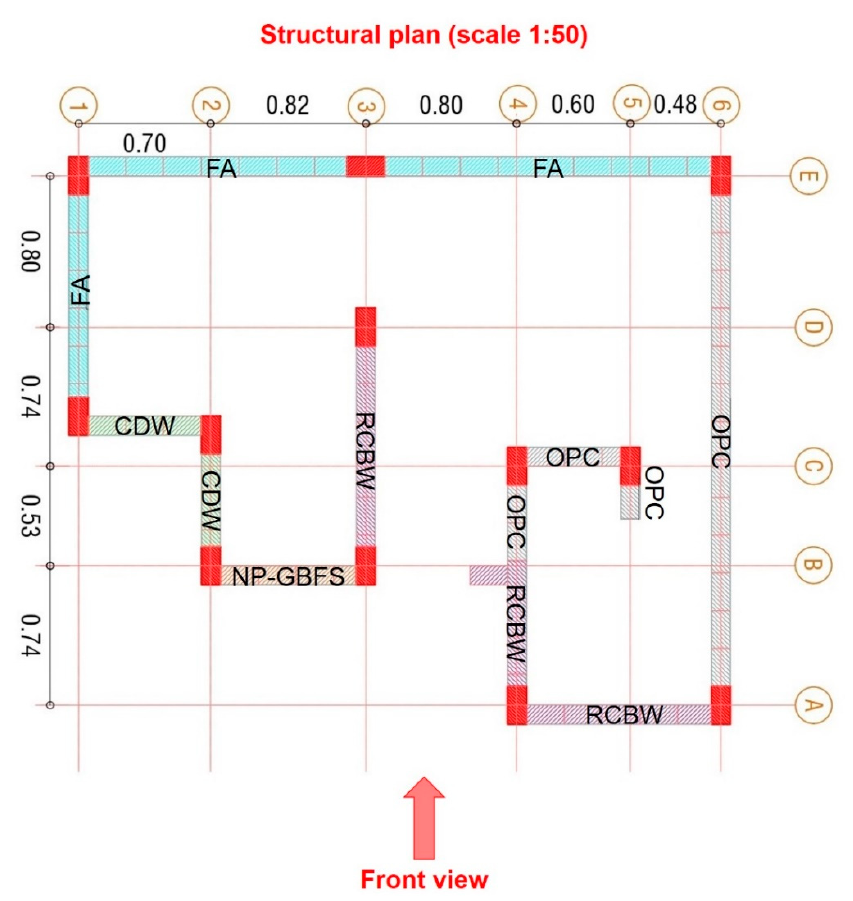
Figure 6. Structural plan of the eco-house prototype (1:50 scale) (distances in m) and definition of the type of block per wall.